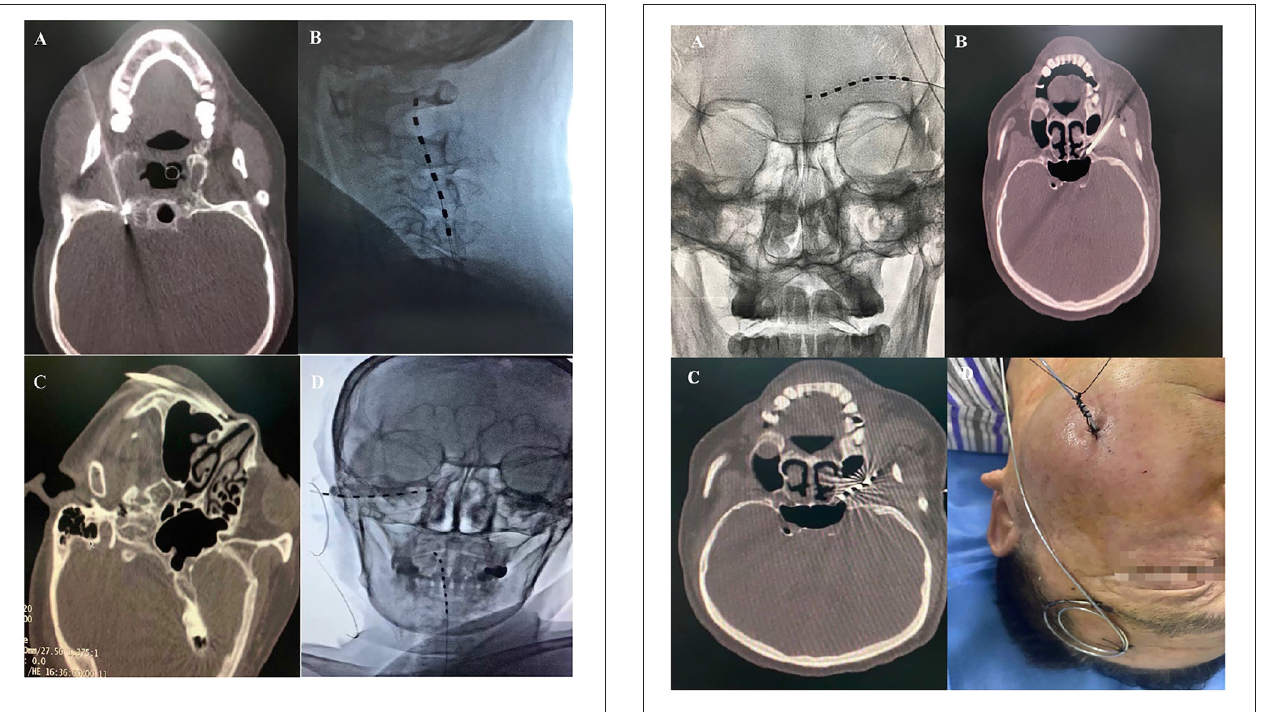
FIGURE 2 | (A) PNS on the left SON and STN. (B) A 14-G needle was placed next to the left external FR opening. (C) The stimulation lead was placed